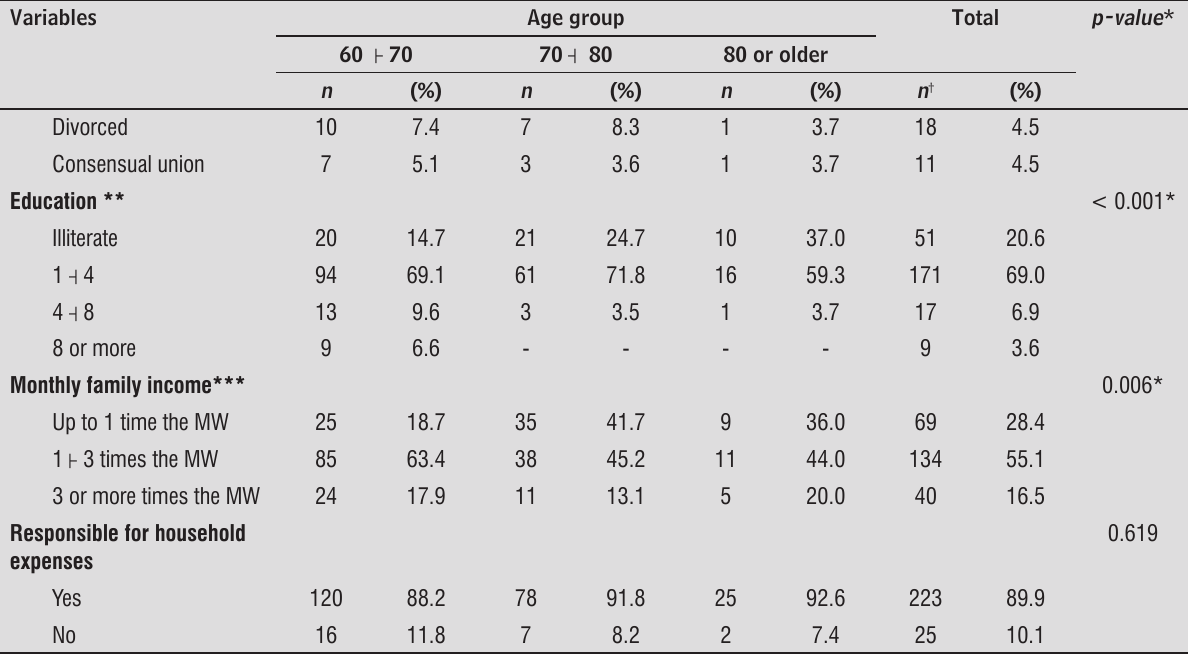
Table 1 - Distribution of socioeconomic and demographic variables by age group. Uberaba, MG, Brazil, 2011 Variables